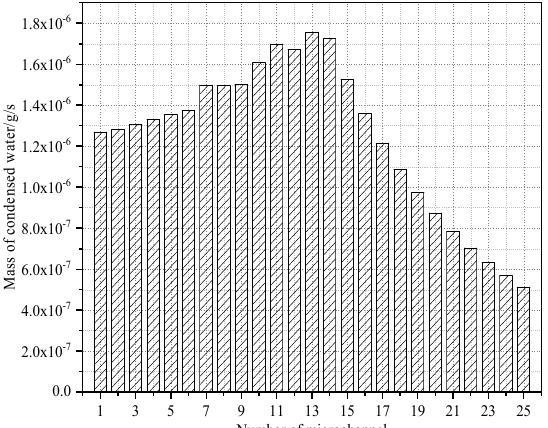
Figure 16. Air temperature change in the airflow direction.